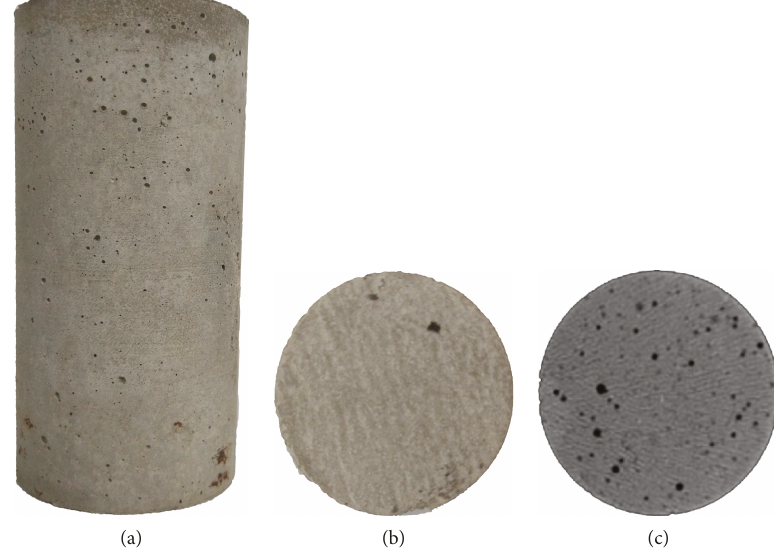
Figure 7: Rock-like sample: (a) vertical section, (b) cross section, and (c) image from CT scanning.